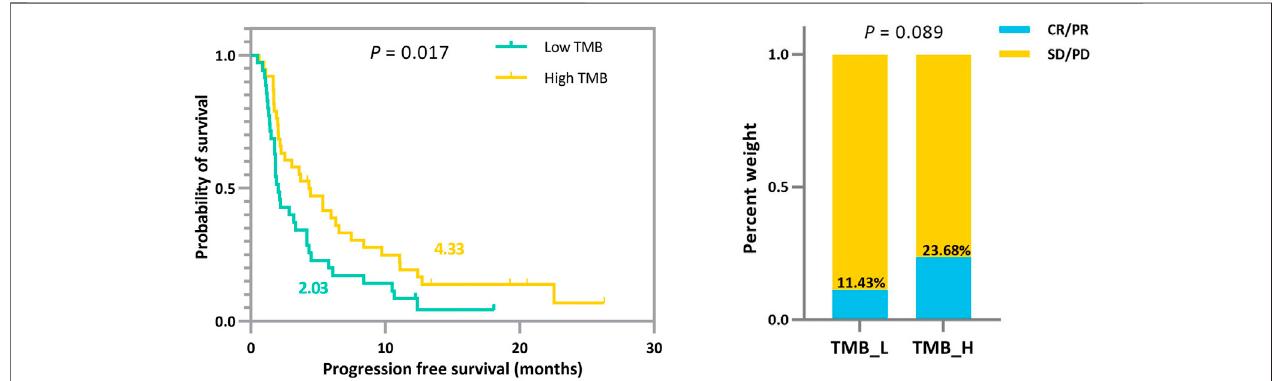
FIGURE6| SurvivalcurvesandORRcomparisonbetweenexperimentalNSCLCpatients( n =73)withlowandhighTMB.Improvedprogression-freesurvival(PFS) and a trend toward increased objective response rate (ORR) are observed in patients with high TMB.